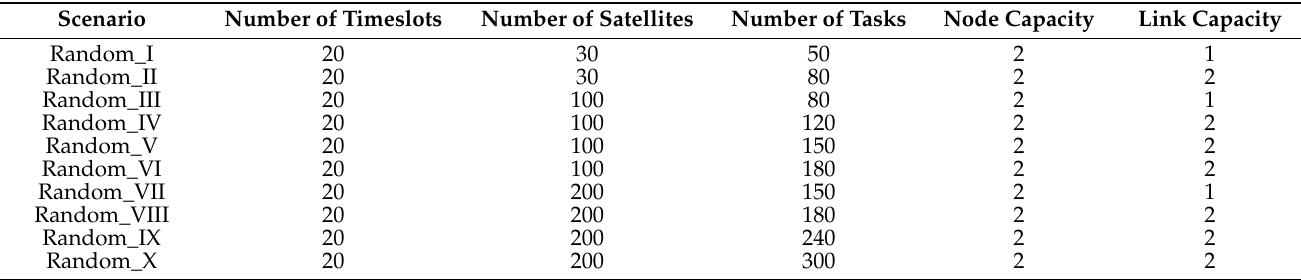
Table 10. Random scenarios